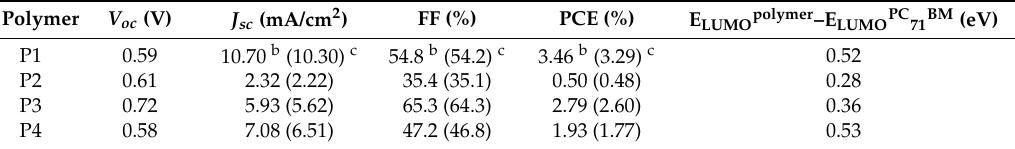
Table 2. Photovoltaic parameters of the device based polymer/PC 71 BM a